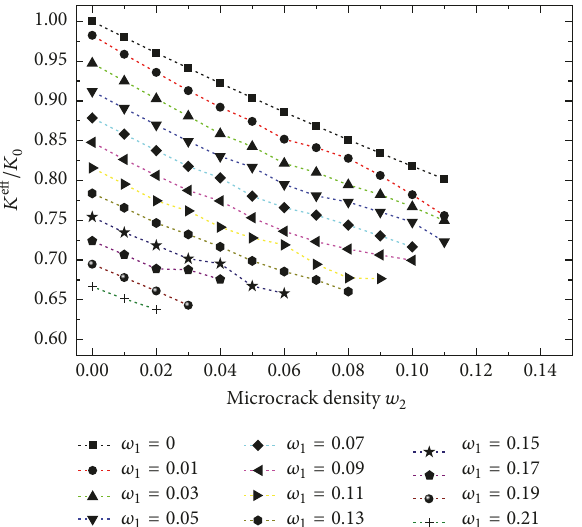
Figure8:Aglobaltranslucentviewofelementdistributioninacube containing randomly distributed microcracks and microvoids.